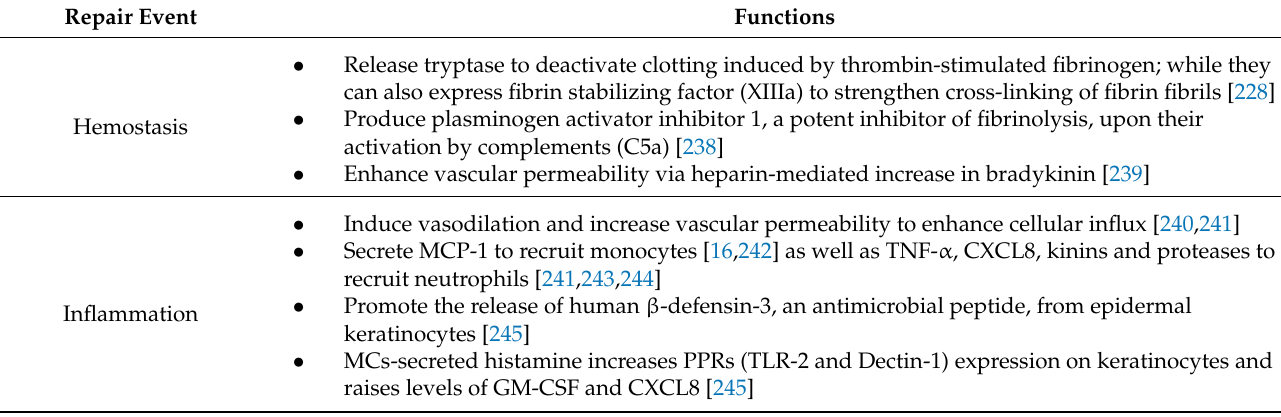
Table 3. Contributions of mast cells to tissue